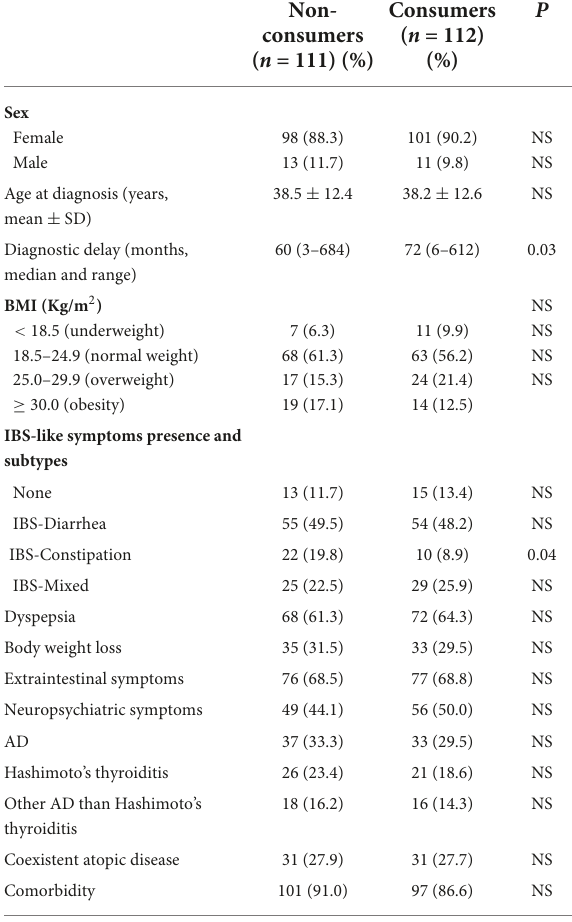
TABLE 2 Demographic and clinical features of NCWS patients according to ancient grain consumption before NCWS